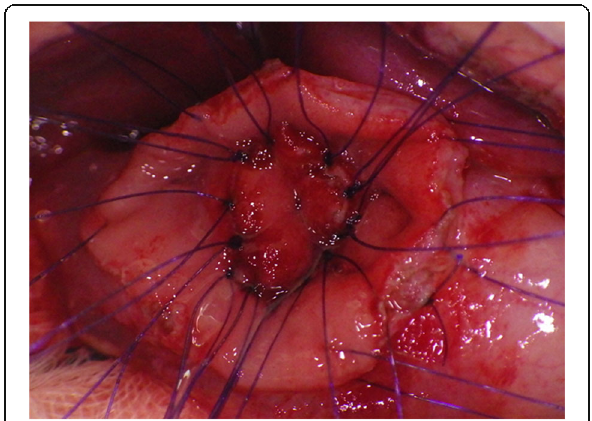
Fig. 5 Intra-operative view, case 1. Marsupialization of the duodenal duplication is performed inside the native duodenum